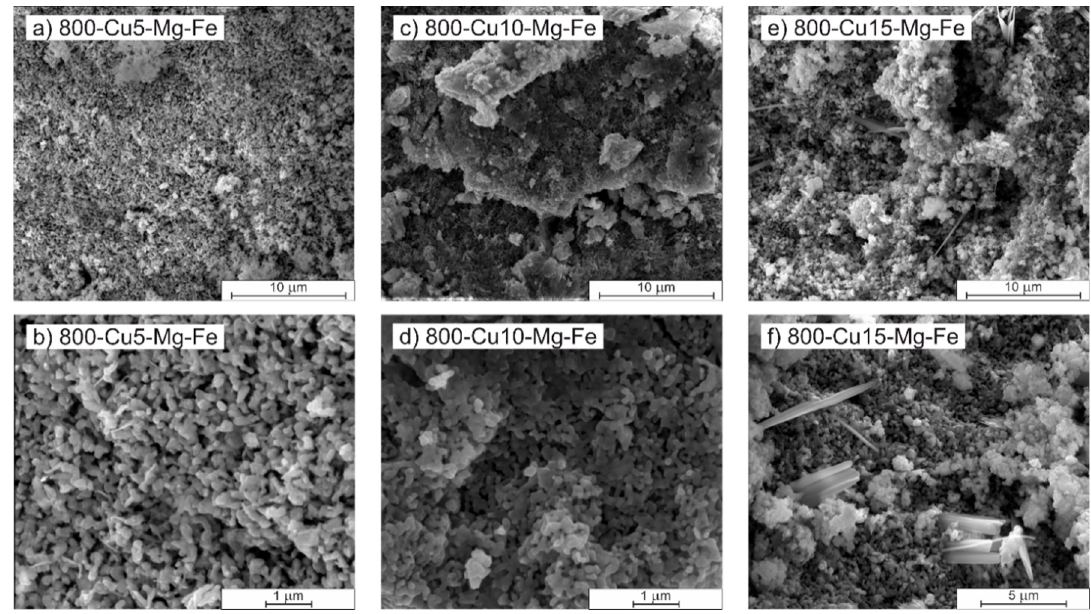
Figure 2. SEM micrographs of ( a ), ( b ) 800-Cu5-Mg-Fe (BSE mode), ( c ), ( d ) 800-Cu10-Mg-Fe (SE mode), ( e ), ( f ) 800-Cu15-Mg-Fe (SE mode).